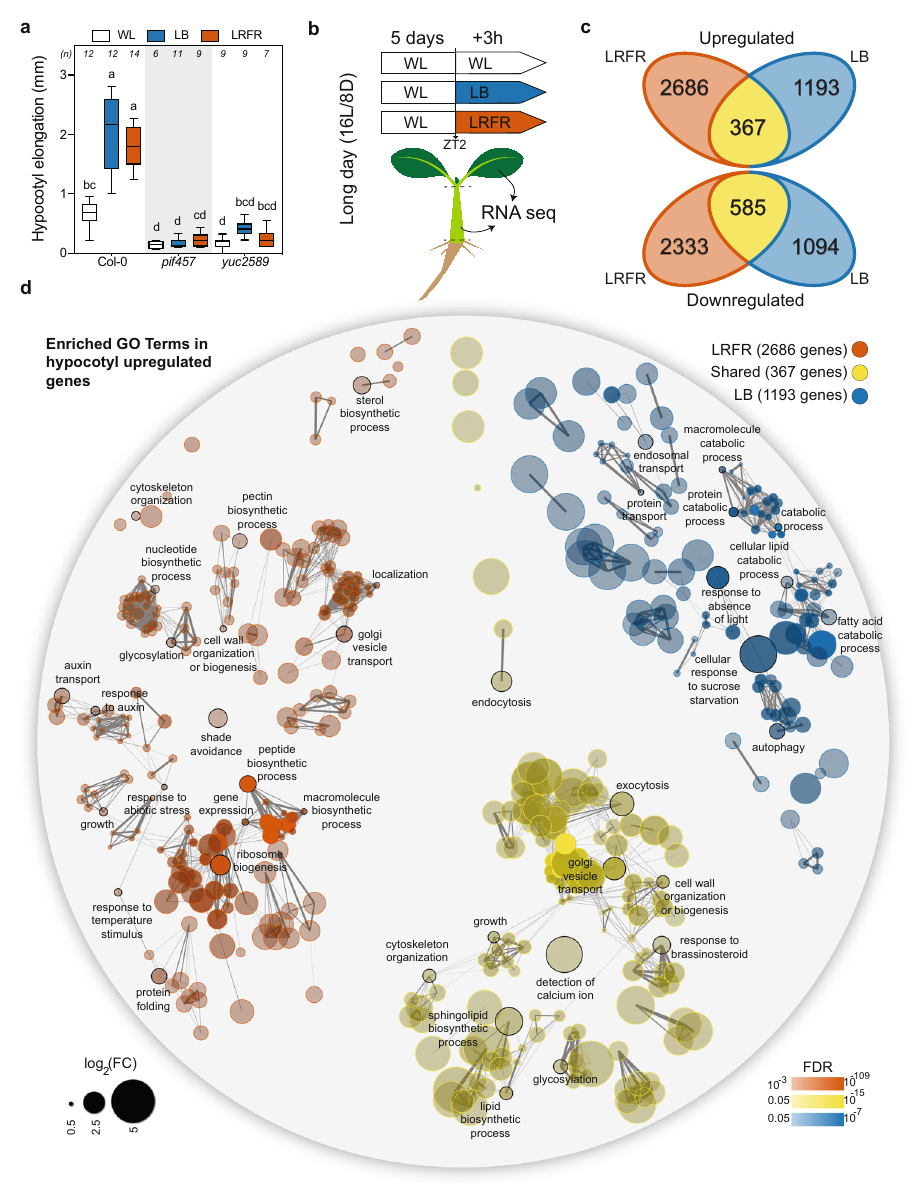
Fig. 1 | LB and LRFR induce distinct transcriptional changes in elongating hypocotyls. a Hypocotyl elongation of the indicated genotypes. The horizontal bar represents the median; boxes extend from the 25th to the 75th percentile, whiskers extend to show the data range. Different letters indicate signi fi cant differences ( P <0.05, two-way ANOVA with Tukey ’ s HSD test; the exact P values are available in the Source Data). Sample size ( n ) that is given on top indicates biologically independent seedlings examined over one experiment. The experiment was repeated two times with similar results. b Schematic summary of the experimental setup used for transcriptome analysis. c Number of up- and